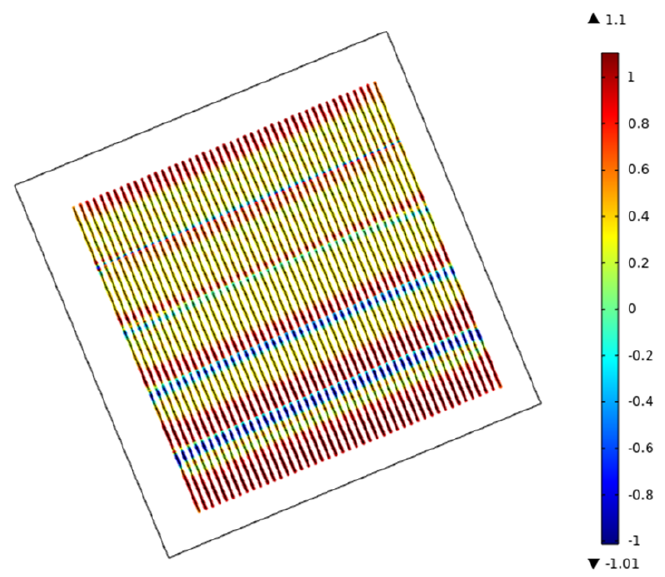
Figure 10. J / J c ( B ) distribution in the coil model.